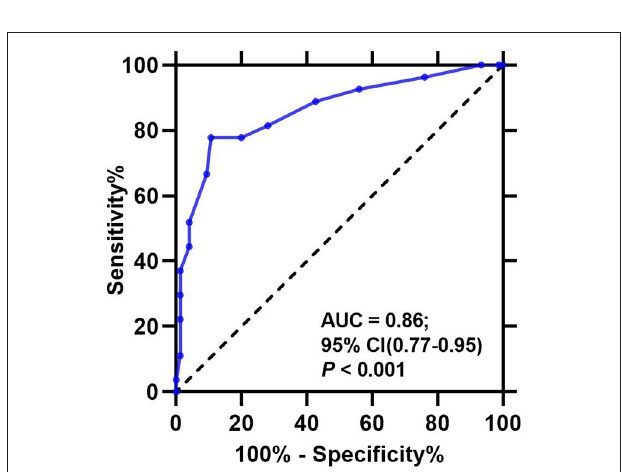
FIGURE 2 | Receiver operating characteristic (ROC) curve for the Test for Respiratory and Asthma Control in Kids (TRACK) initial scores. AUC, area under the